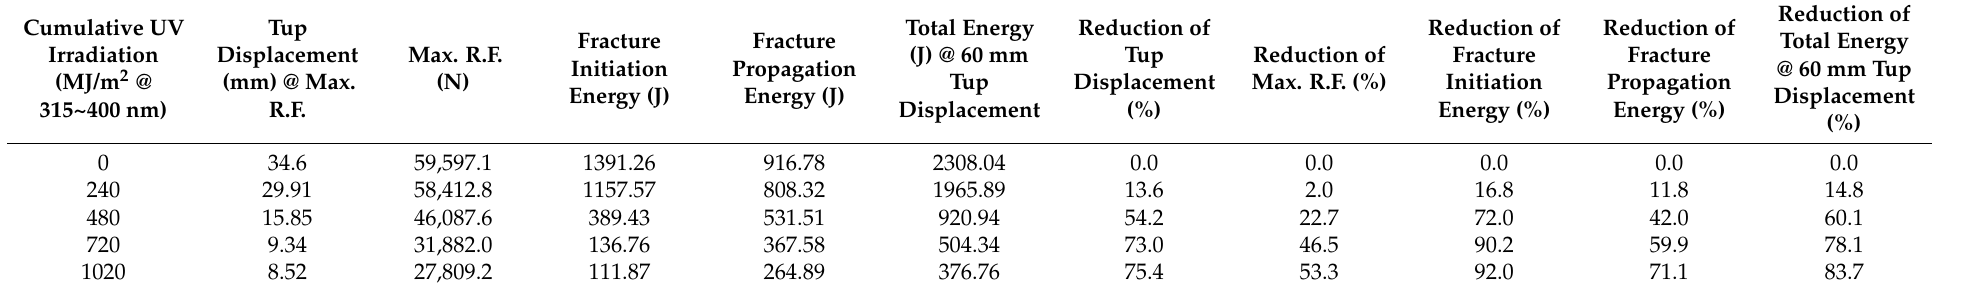
Table 6. Summary of impact analysis for weather-exposed PC channel